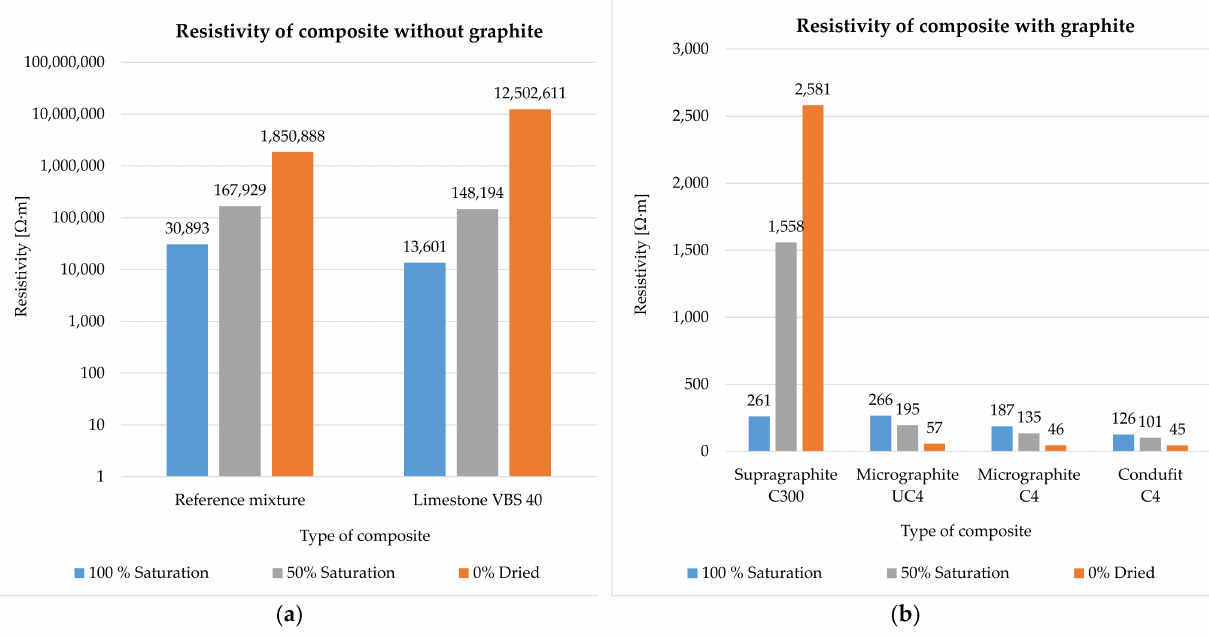
Figure 11. The comparison of resistivity of silicate composites at 100%, 50% and 0% water saturation, samples: ( a ) without the content of graphite; ( b ) with the content of